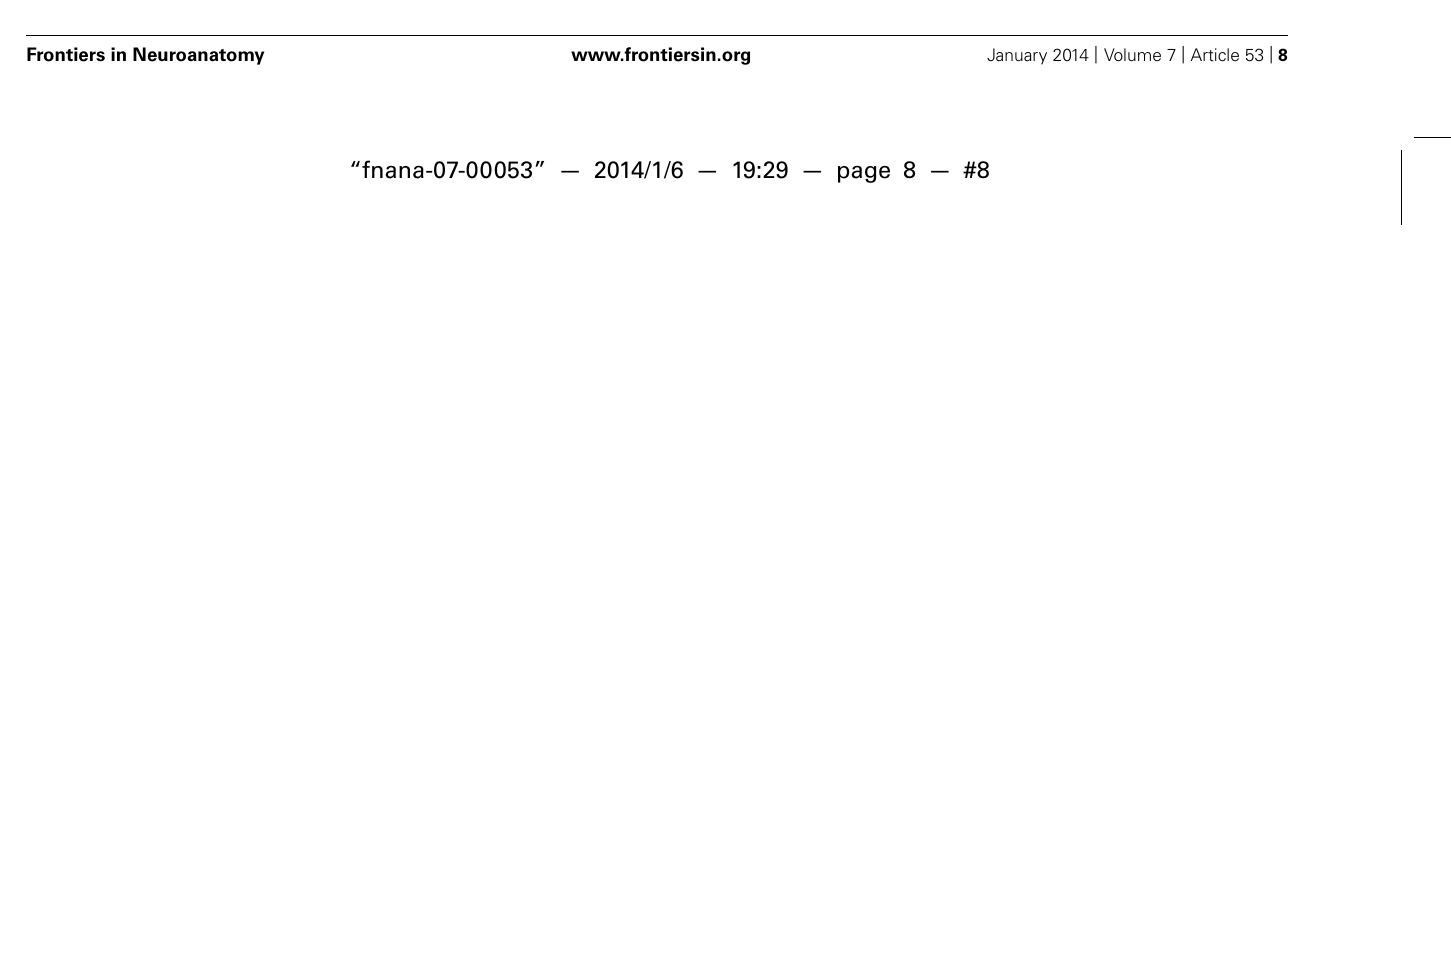
FIGURE 8 | Merged photomicrographs showing anti-VAChT labeled PNs surrounding either GAD+ cells (arrows) or a GAD-negative cell (arrowhead). A GAD + cell without an anti-VAChT labeled PN is also present (asterisk). Images from ICc. Scale bar = 10 μ m. Case GP613.